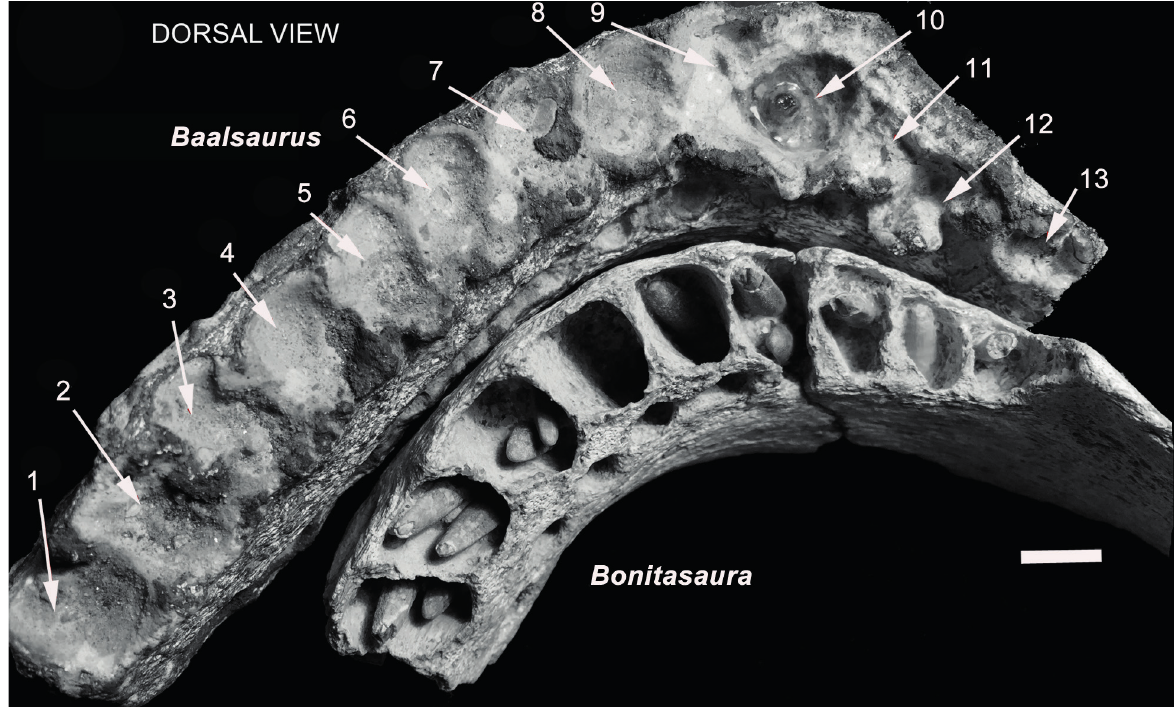
Figure 3 - showing alveoli in dorsal view of Baalsaurus mansillai n.g.n.sp. compared with Bonitasaura salgadoi. Scale bar: 1